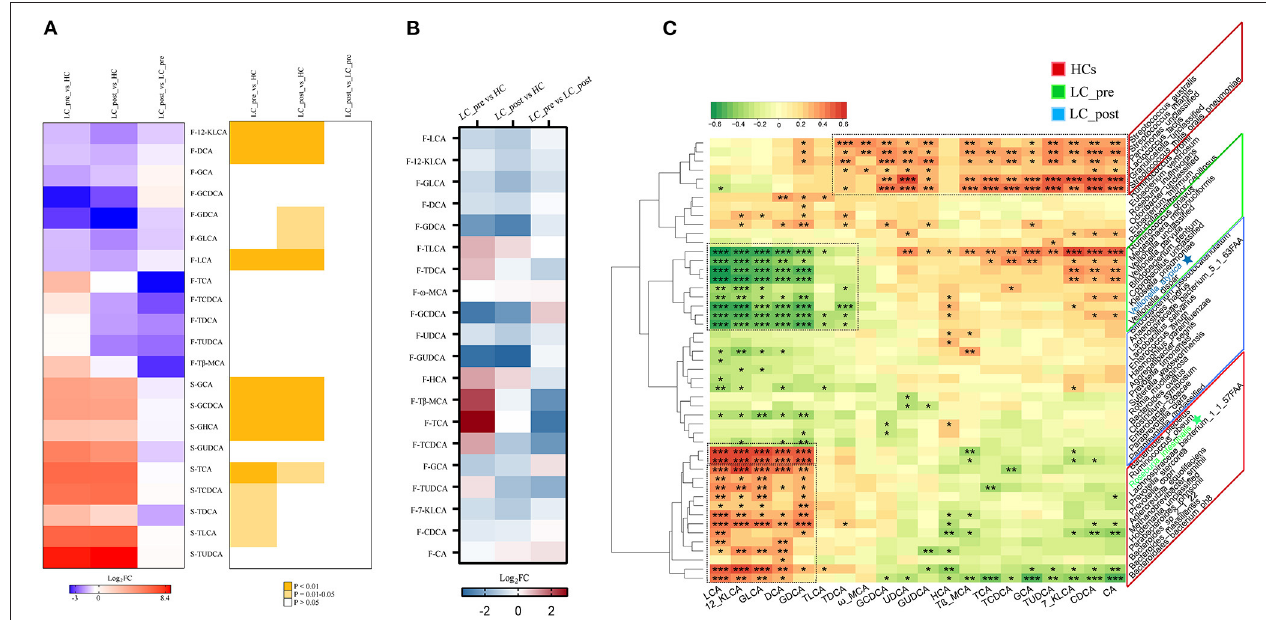
FIGURE 6 | Effect of lactitol on fecal and serum BAs. (A) Discriminatory BA levels (Foldchange > 2) and associated P values for LC-pre vs. HC, LC-post vs. HCs, and LC-pre vs. LC-post. (B) Heatmap of fecal BAs. (C) Correlation between fecal BAs and discriminatory species. BAs, bile acids; LC-pre (green), cirrhotic patients before lactitol intervention; LC-post (blue), cirrhotic patients before after lactitol intervention; HCs (red), healthy controls. Benjamini–Hochberg correction was further applied to adjust derived p -values. Only pathways with p -values under a threshold of 0.05 were considered as significant. * p < 0.05, ** p < 0.01, *** p <